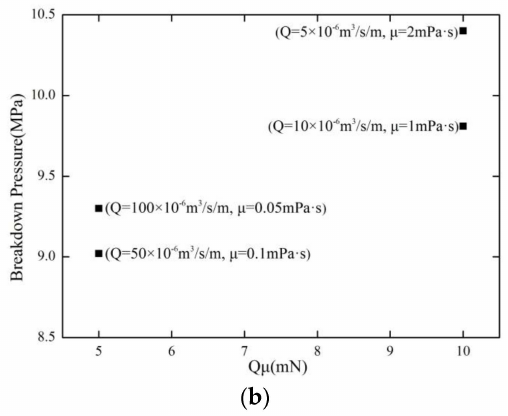
Figure 14. The relationship between Q µ and hydraulic fracturing characteristics. ( a ) relationship between Q µ and the fracture aperture; ( b ) relationship between Q µ and the breakdown pressure.